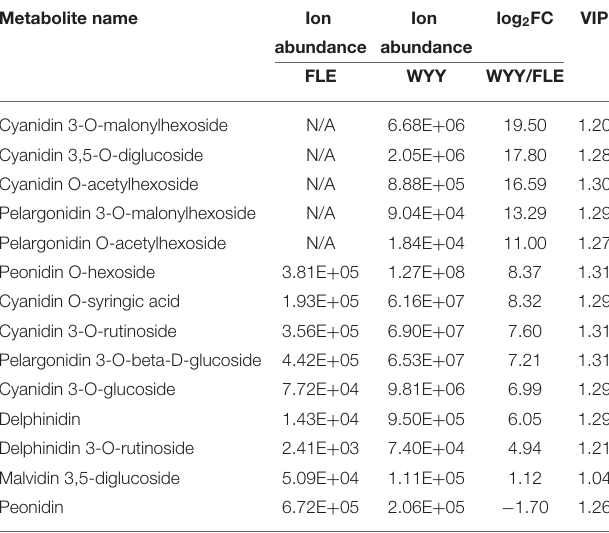
TABLE 1 | Differentially expressed anthocyanins in WYY and